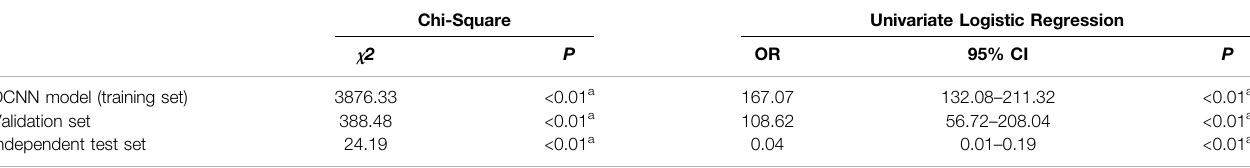
TABLE 3 | Correlation of the DCNN model and actual events.